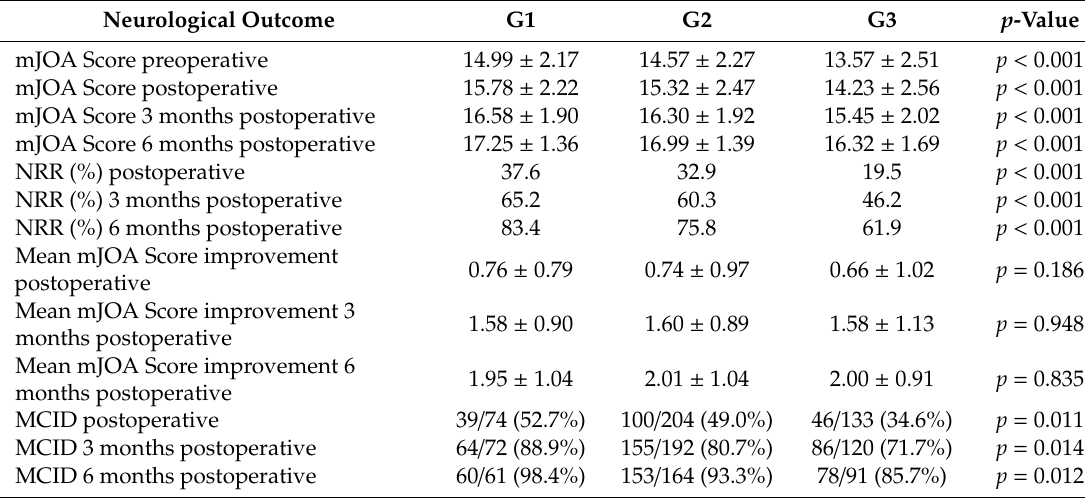
Table 2. Modified Japanese Orthopedic Association Score (mJOA Score), neurological recovery rate (NRR) and the mean mJOA Score improvement according to the age groups (G1–G3) postoperative, three and six months after surgery.